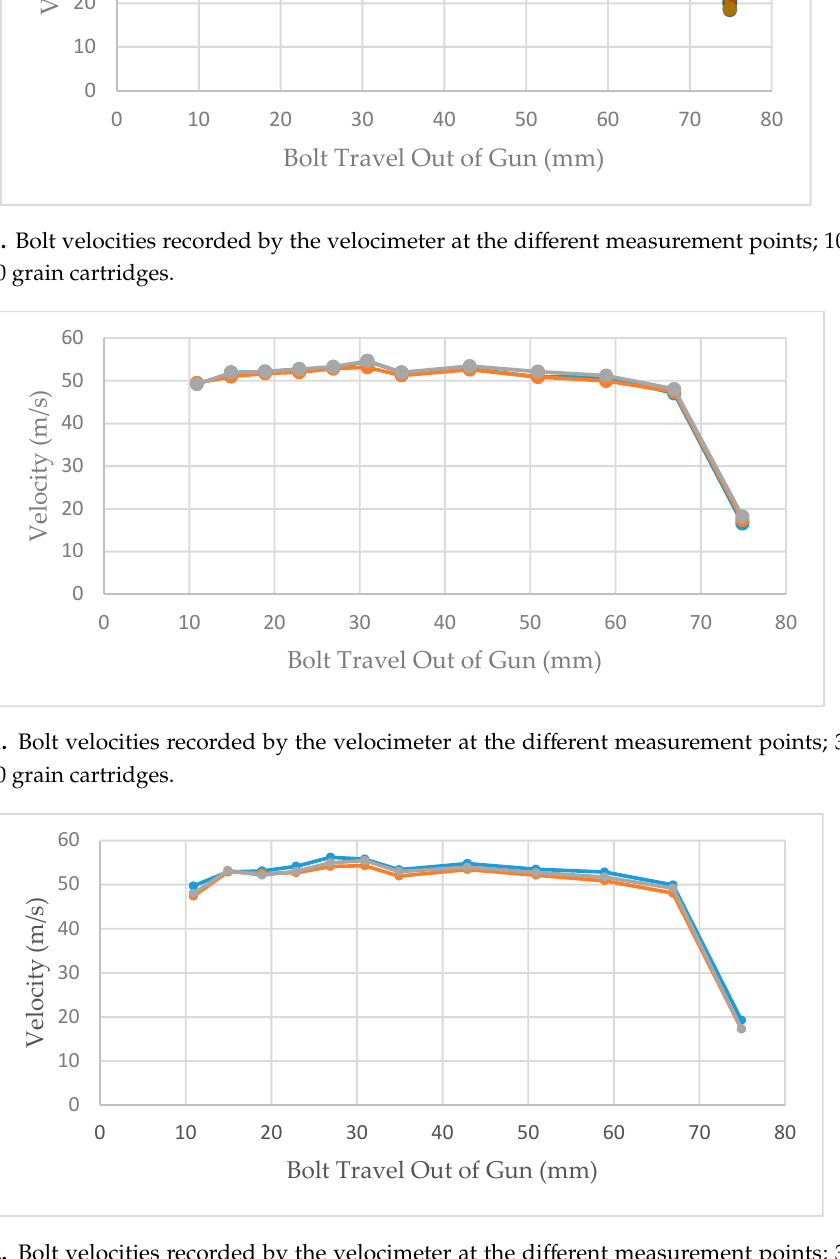
Figure 12. Bolt velocities recorded by the velocimeter at the different measurement points; 3 shots using 3.00 grain cartridges.